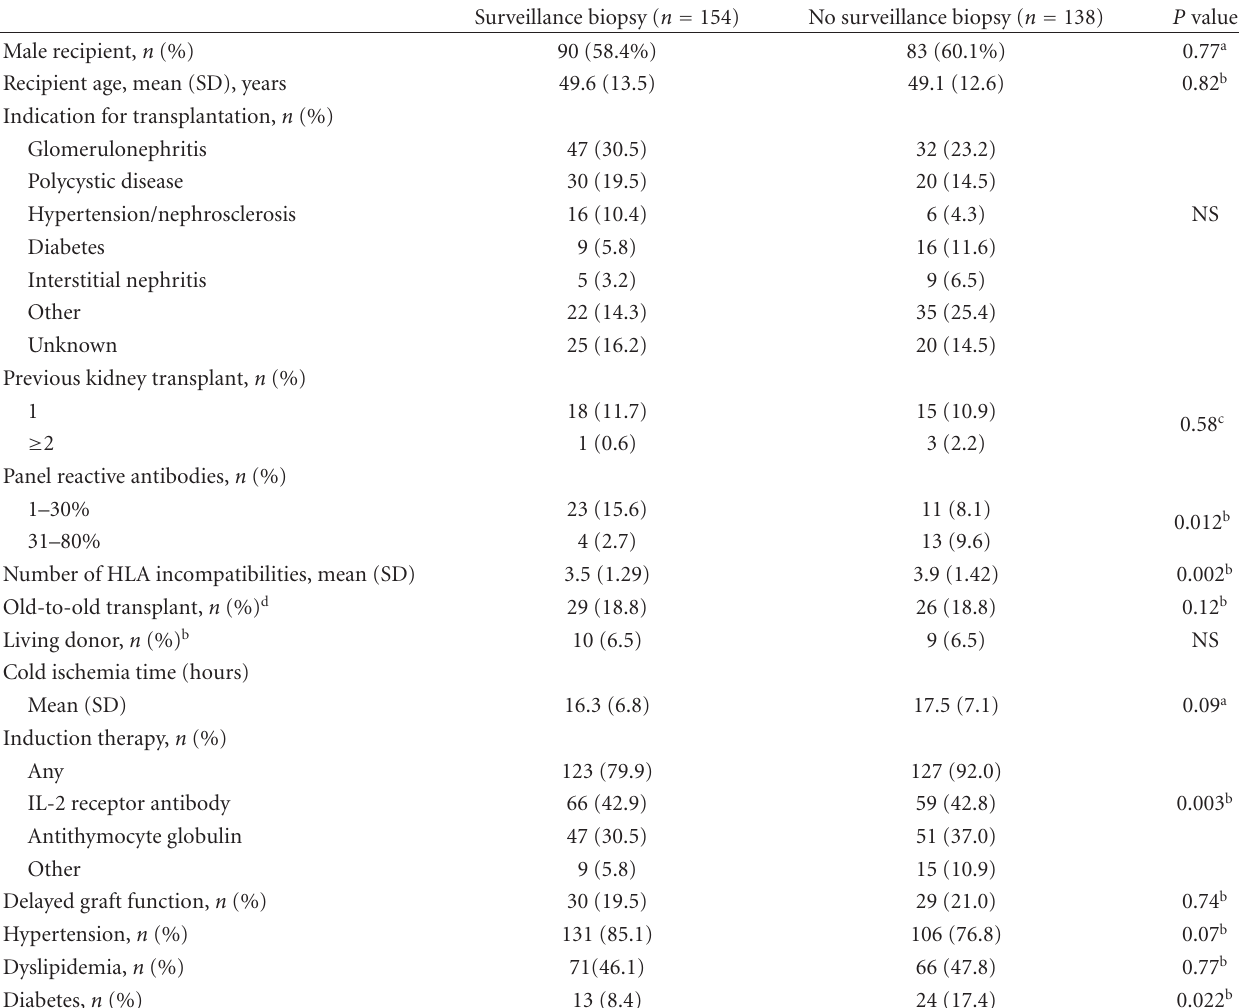
Table 1: Baseline